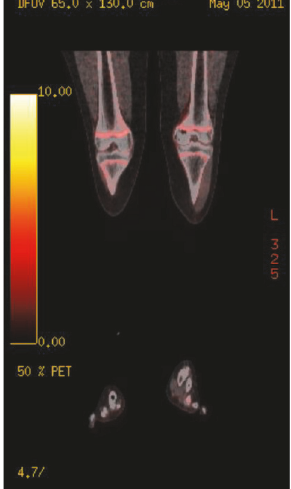
Figure 10: Fludeoxyglucose-positron emission tomography (FDG- PET), May 2011. Non-FDG-avid mixed sclerotic and lytic lesion of theleft medial femoral condyle,consistentwith resolved